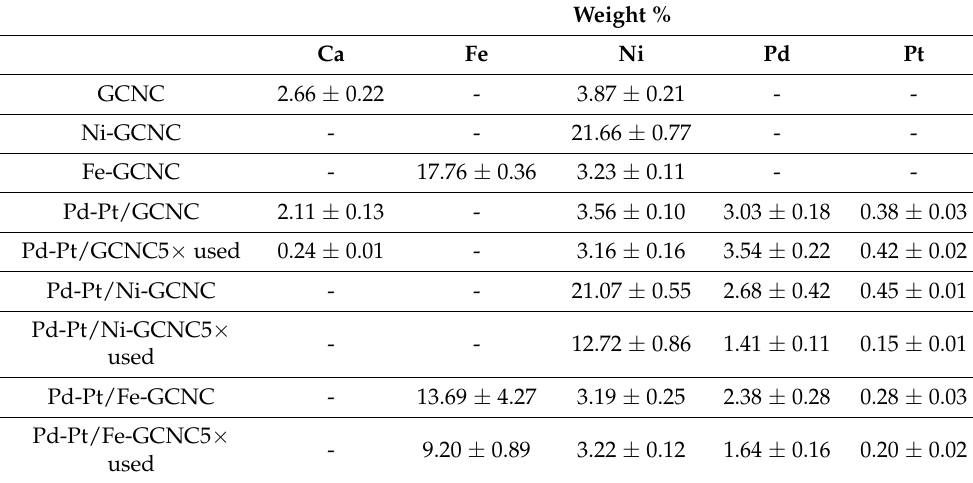
Table 2. Quantitative analysis of the granulated carbon nanocomposite supported Pd-Pt decorated catalysts based on ICP-OES measurements.